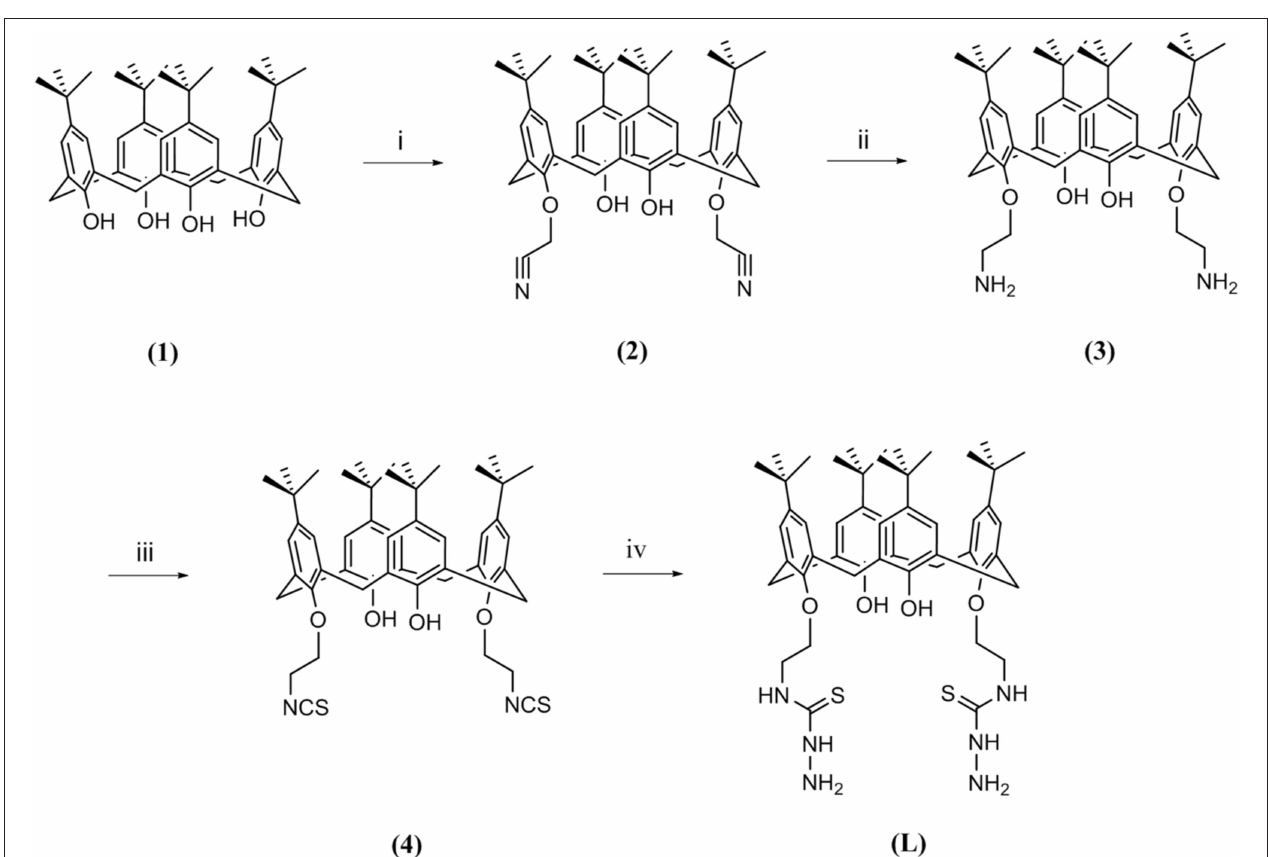
FIGURE 1 | Route followed for the synthesis of ligand L ; (i) chloroacetonitrile, K 2 CO 3 , NaI, reflux, 7h; (ii) LiAlH 4 , (0 ◦ C), 4h; (iii) CSCl 2 , BaCO 3 , 24h; (iv) hydrazine hydrate, room temperature, 3h.